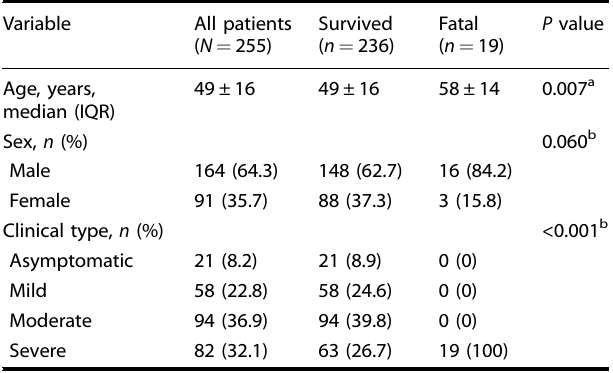
Table 1. Basic characteristics of the COVID-19 patients